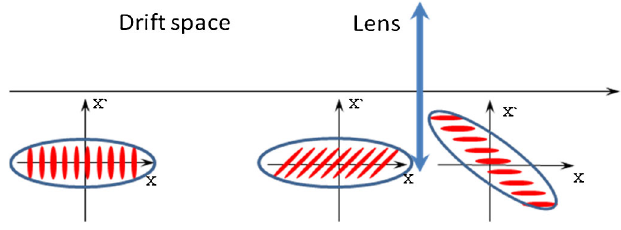
FIG. 2. Optics to mix the horizontal position and horizontal divergence to provide an additional degree of freedom in EEX